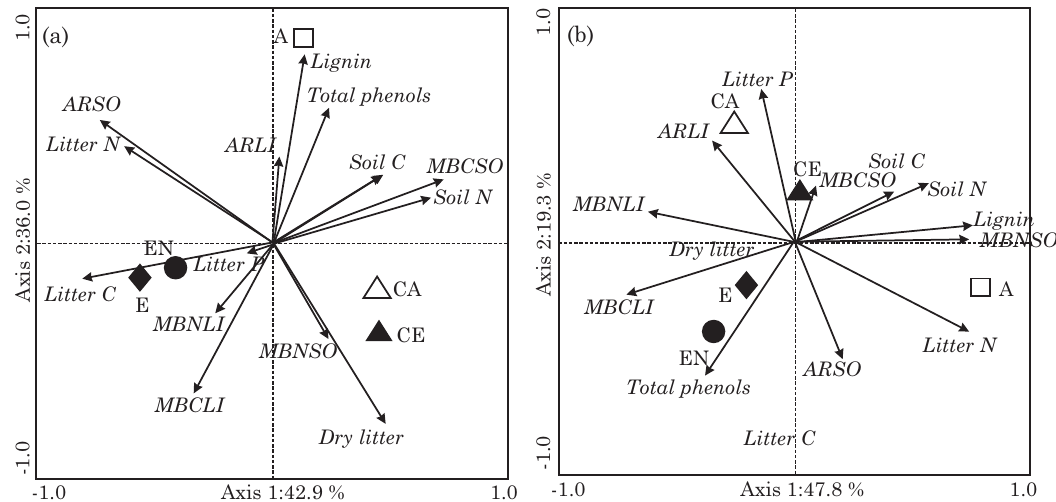
Figure 3. Principal component analysis of the chemical and microbiological variables of soils and litter seven (a) and 14 months after planting (b). (A) A. mangium monoculture; (E) E. grandis monoculture; (EN) E. grandis monoculture with N fertilizer; (CA) mixed plantation (at the stem base of A. mangium ); (CE) mixed plantation (at the stem base of E. grandis ). ARSO (accumulated respiration of the soil); ARLI (accumulated respiration of the litter); MBCSO and MBNSO (Microbial biomass C and N of soil, respectively); MBCLI and MBNLI (Microbial biomass C and N of litter, respectively).